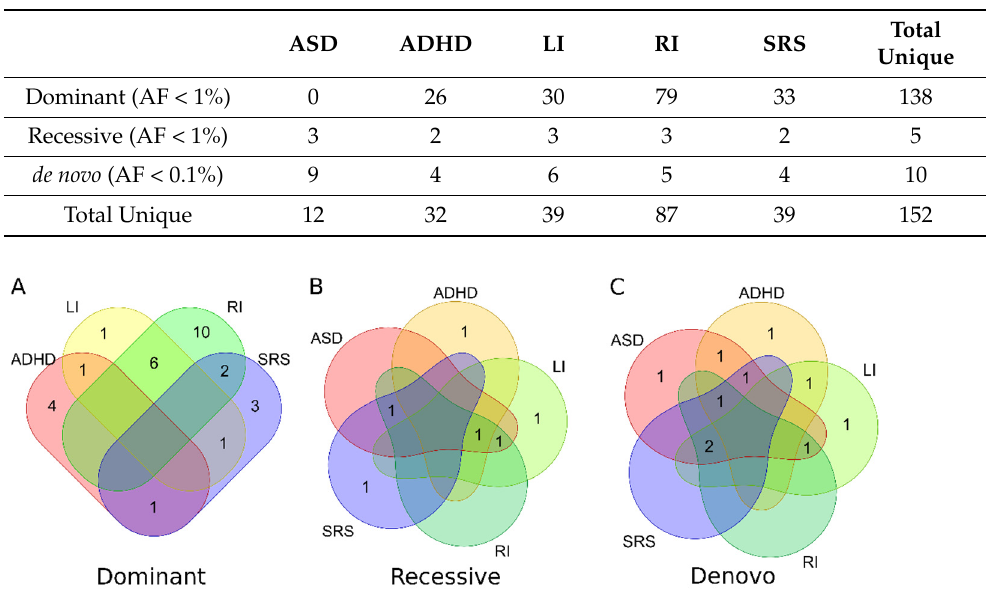
Figure 3. Number of families with 3 ′ UTR variants. Venn Diagrams of families with 3 ′ UTR variants for each inheritance pattern: ( A ) Dominant; ( B ) Recessive; ( C ) de novo . The value indicates the num- ber of families with candidate variants for the